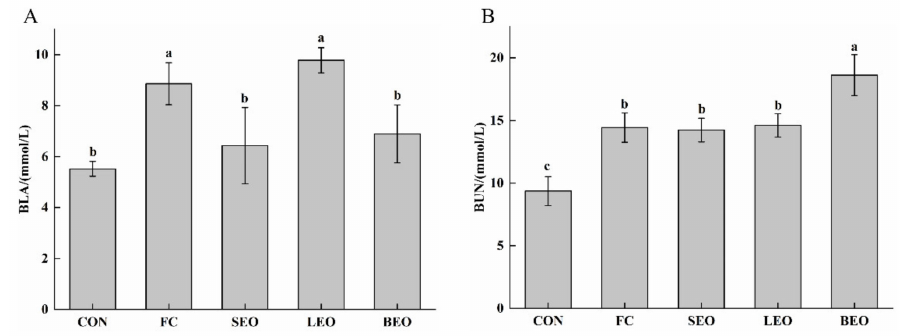
Figure 4. Effects of the inhalation of the CEOs on metabolite accumulation in exercise-induced fatigue rats. ( A ) BLA in serum, ( B ) BUN in serum. Data are the means ± SD. Different lowercase letters indicate significant differences, p <